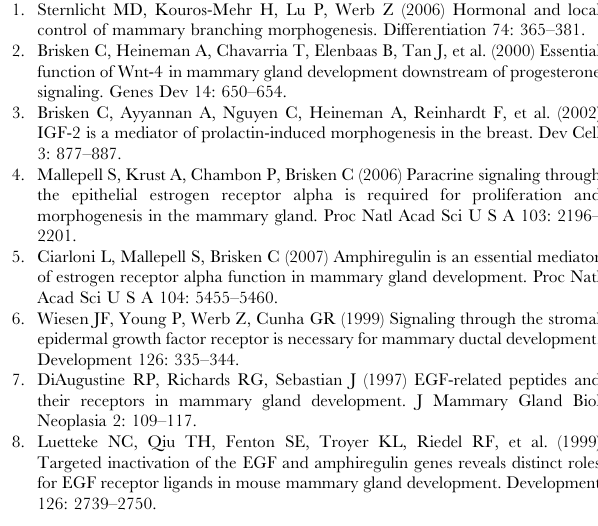
Figure S2 Viable cell count by trypan-blue exclusion staining at 48 h of MCF-10A and NMuMG cells cultivated in growth medium and the indicated inhibitors (AG/ A = AG1478 250 nM; PHA/P = PHA-675752 250 nM) in presence or absence of HGF 10 ng/ml (H). Untreated control (Ctrl) was set to 100%. Columns, mean (n= 6); bars, Figure S3 A/B Viable cell count by trypan-blue exclu- sion staining at 48 h of ErbB2 tumor cells cultivated in growth medium and the indicated inhibitors (AG/ A = AG1478 PHA/P = PHA-675752 250 nM; presence or absence of HGF 10 ng/ml (H). Untreated control (Ctrl) was set to 100%. Columns, mean (n =6); bars,